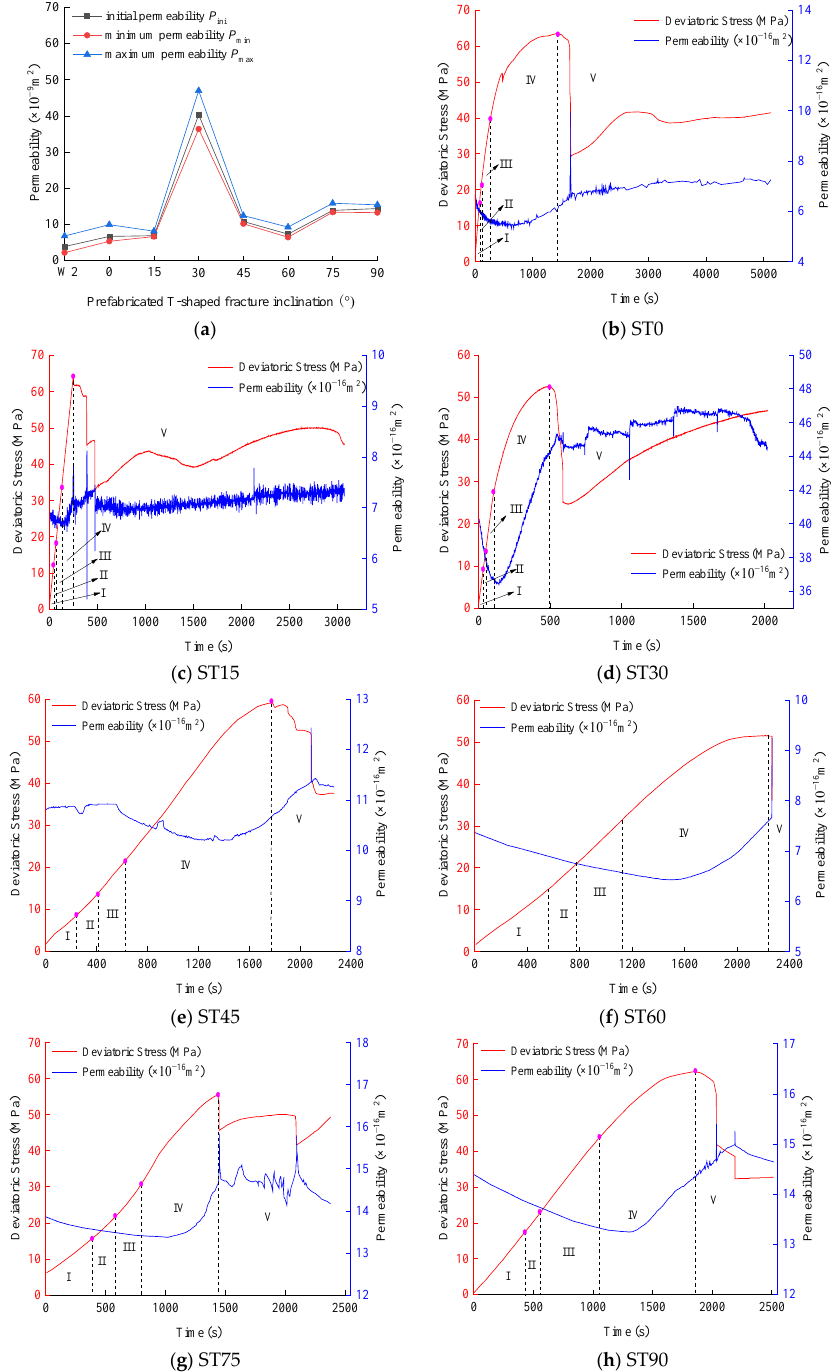
Figure 10. Variation of permeability characteristic points with different incliation fracture speci- mens:( a ), Relationship between stress, permeability and time of T - shaped fracture specimen:( b – h ).